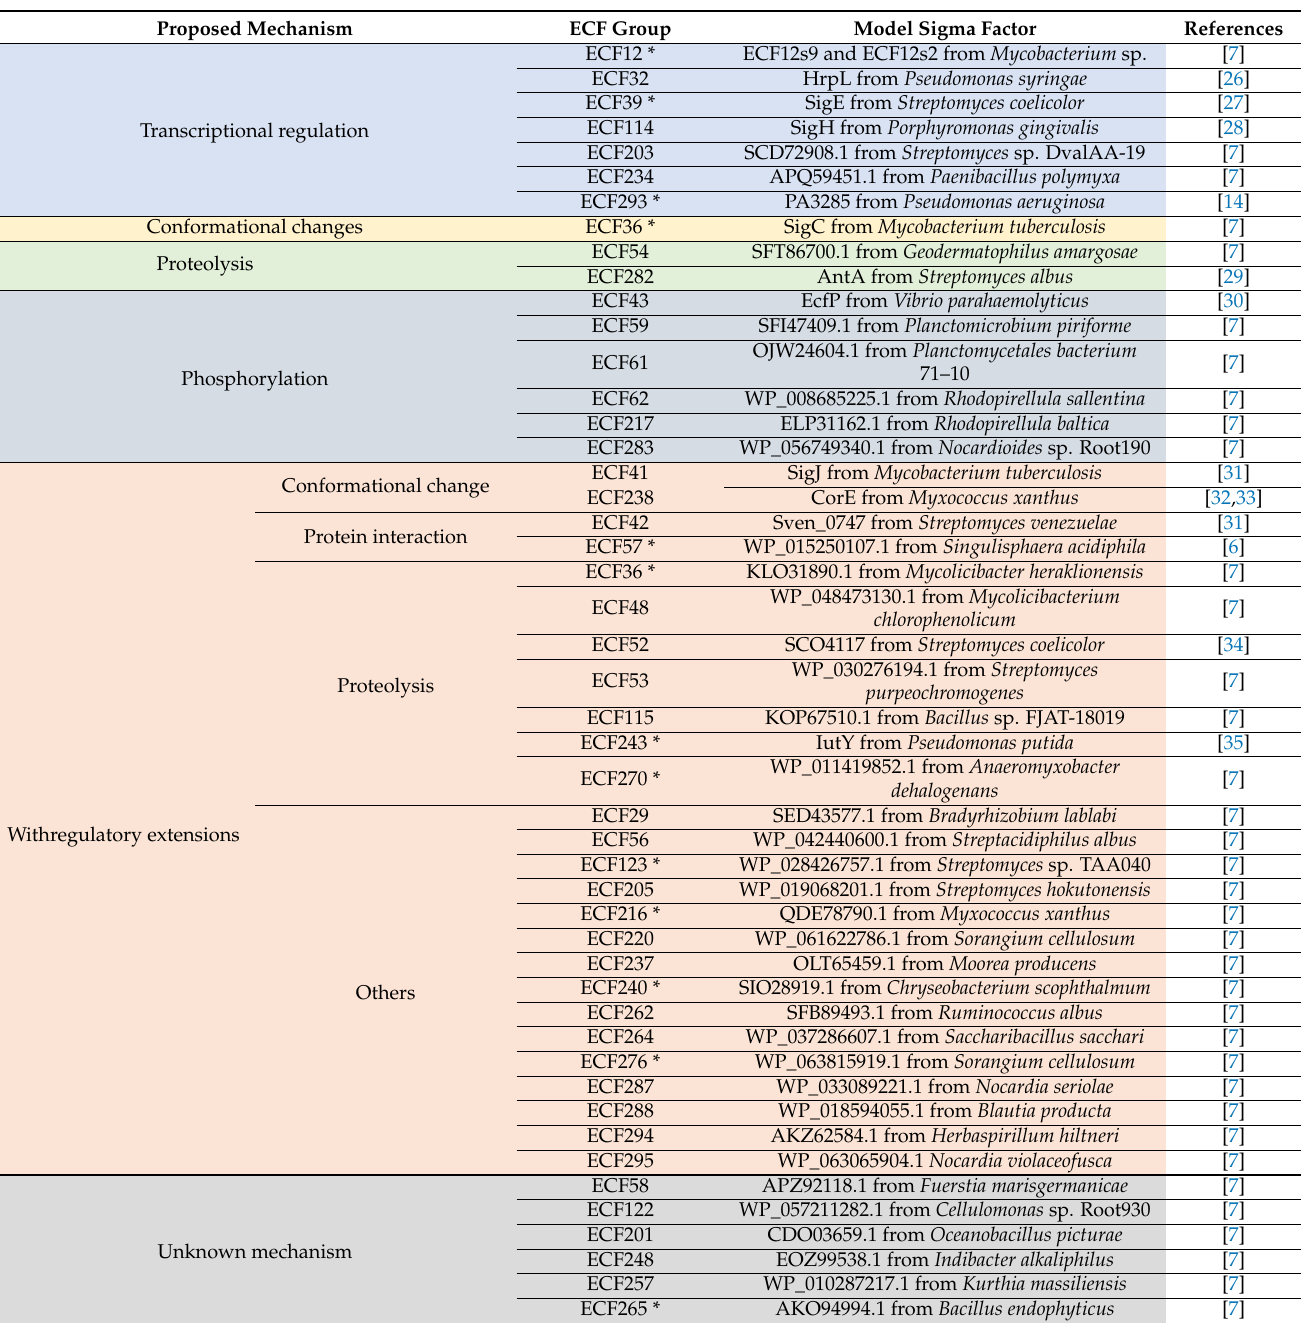
Table 2. Regulatory mechanisms of the ECF sigma factors without anti-sigma factor. The ECF groups are those that appear in the new classification by Casas-Pastor et al., 2021 [7]. * Only certain members of the